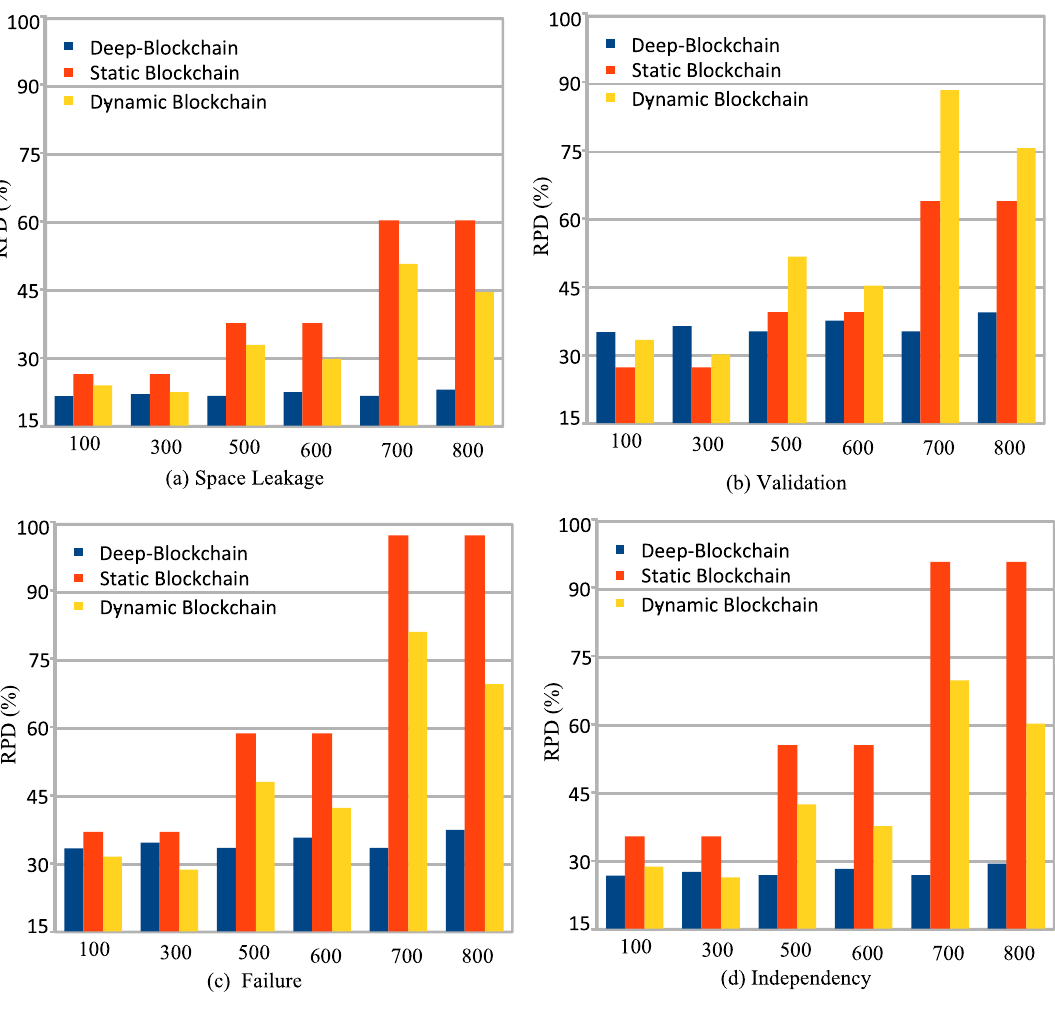
Figure 4. Blockchain-enable data transitions in mobile fog cloud